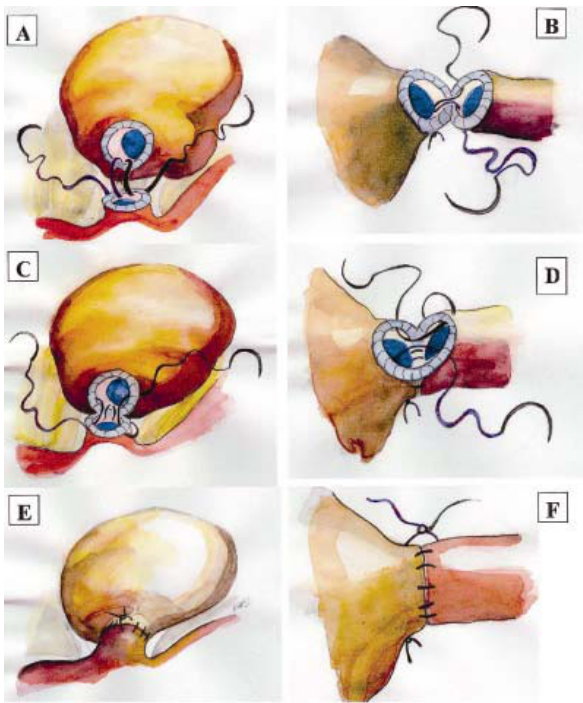
FIGURE 4 . Single-knot method for laparoscopic running urethrovesical anastomosis. (Reprinted from Urology 61(4), 699–702, 2003. With kind permission from